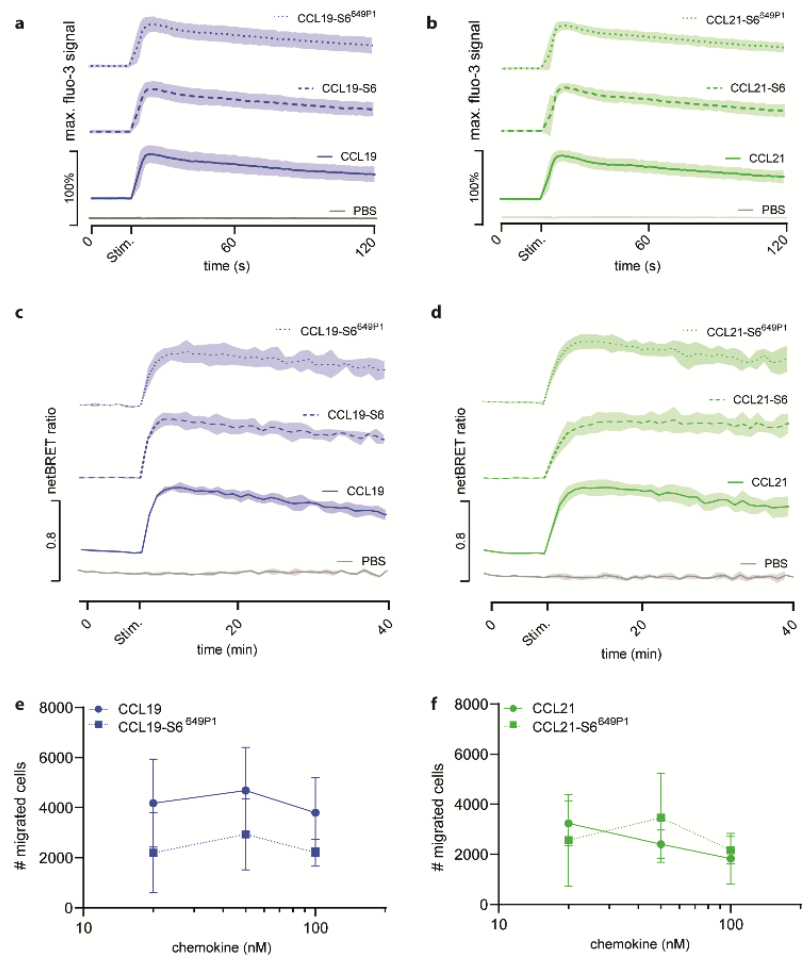
Figure 3. Fluorescent CCL19-S6 649P1 and CCL21-S6 649P1 efficiently elicit CCR7-mediated signaling and migration. ( a , b ) Pre-B 300-19 cells stably expressing CCR7 were stimulated with 50 nM of the indicated CCL19 ( a ) and CCL21 ( b ) chemokine variants and changes in intracellular calcium levels were recorded by flow cytometry over time. The time point of stimulation (Stim.) is indicated. Stimulation with PBS, the chemokine solvent, served as negative control. Mean values ± SD of three independent experiments are shown. ( c , d ) HeLa cells transiently transfected with CCR7-EGFP and β -arrestin2-Nluc were stimulated with 500 nM of CCL19, CCL19-S6, or CCL19-S6 649P1 ( c ), and 1.5 µ M CCL21, CCL21-S6, or CCL21-S6 649P1 ( d ), respectively, and chemokine-mediated β -arrestin2